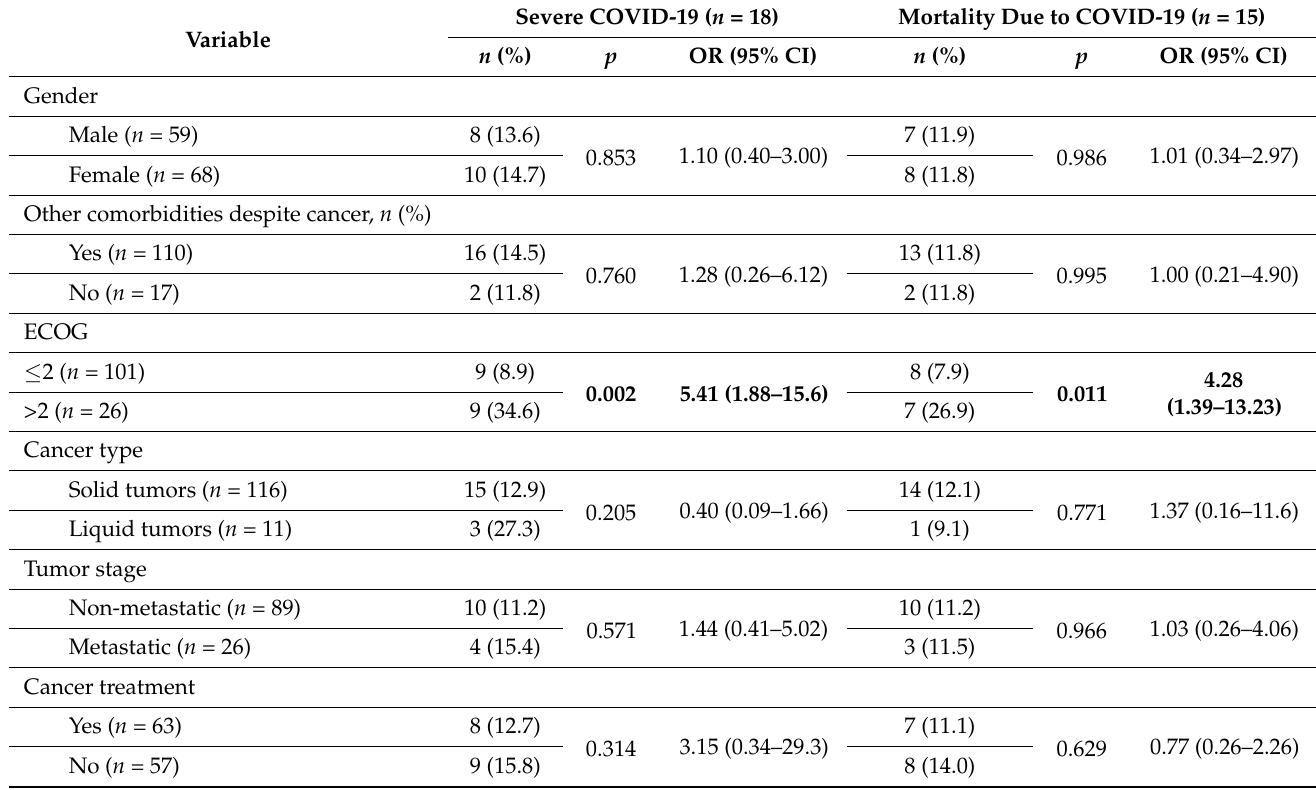
Table 3. Univariate analysis of clinicopathological characteristics impact in COVID-19 severity and mortality.